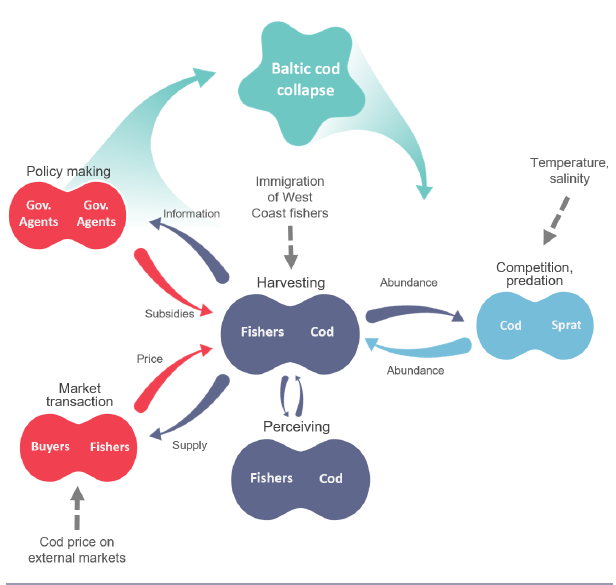
Fig. 3 . Social-ecological action situations (SE-AS) representation of the configuration of social-ecological (dark blue), social (red), ecological action situations (light blue) hypothesized to have caused the cod collapse in the Baltic